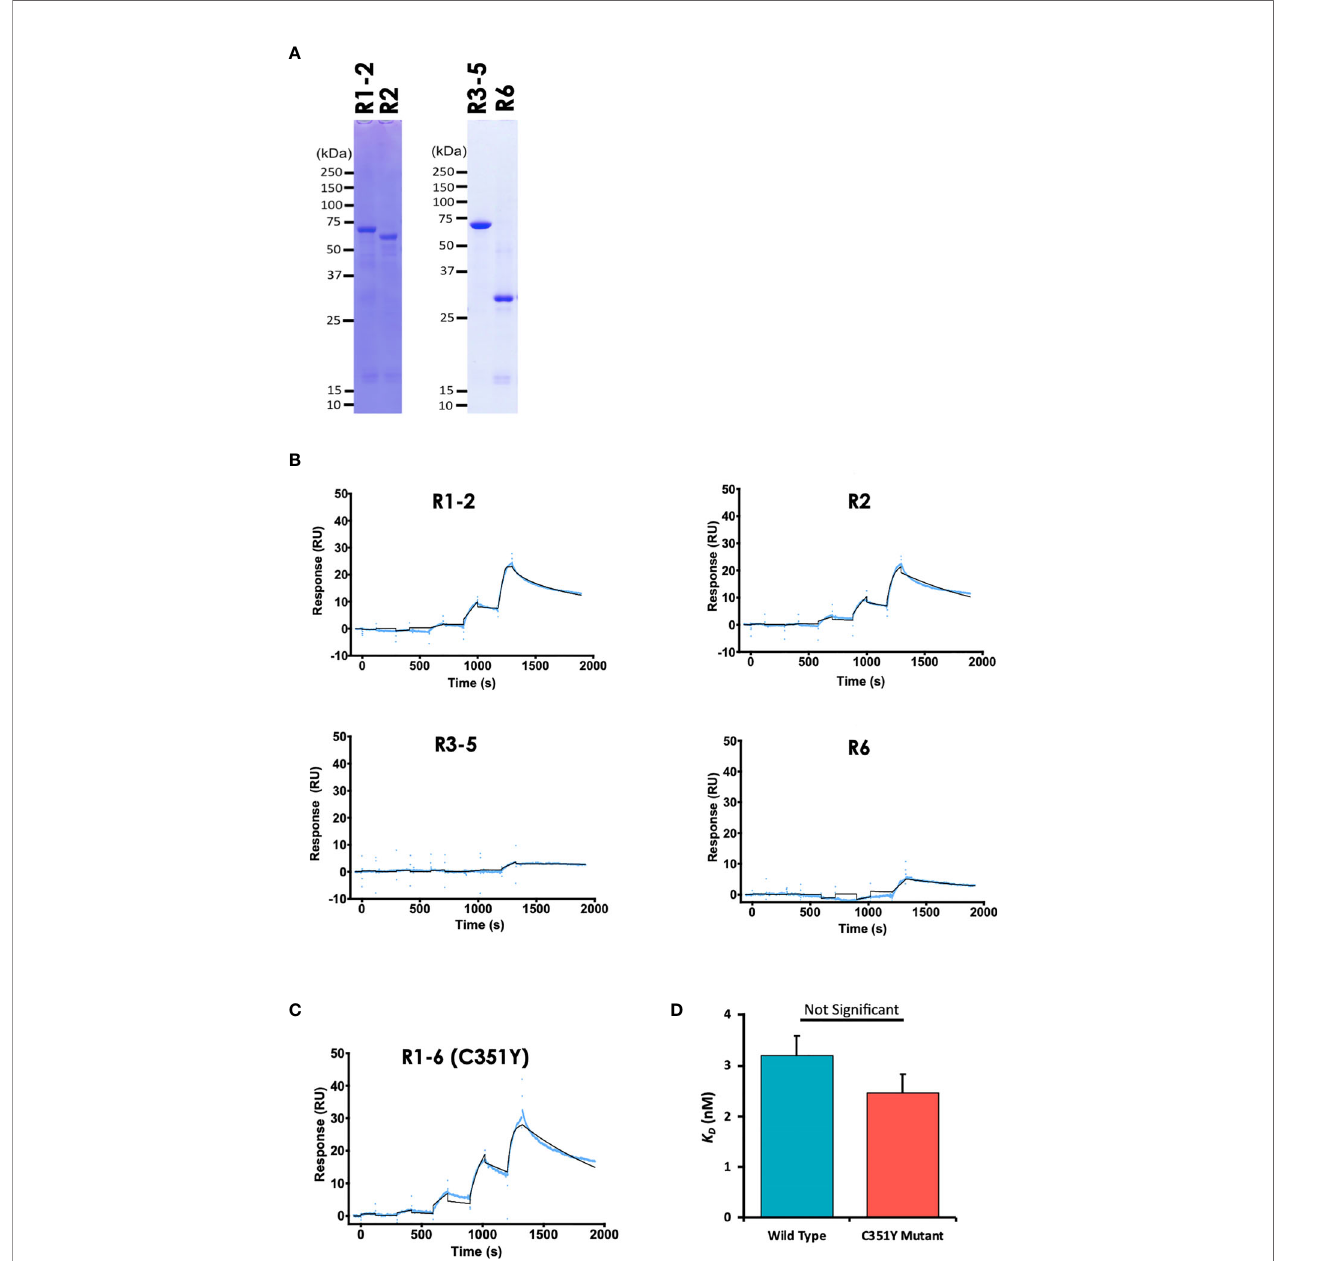
FIGURE 2 | PyEBL interacts with basigin via the Region 2, the Duffy binding-like domain . (A) Recombinant PyEBL truncates namely R1-2, amino acid V 28 -G 437 ; R2, E 113 -G 437 ; R3-5, G 437 -C 717 ; and R6, C 717 -N 788 were expressed as N-terminal GST, C-terminal His-tagged proteins were puri fi ed with Ni-af fi nity columns, resolved by 12.5% SDS-PAGE under reducing conditions, and stained with CBB. Different truncates are shown. (B) Sensorgram of SPR single-cycle kinetic analysis between recombinant PyEBL truncates and recombinant mouse basigin. The SPR Chip used was same as used in Figure 1D with GST tagged Basigin as the analyte. The blue curve represents the actual data-generated sensorgram while the black curve indicates line of fi t used to calculate kinetics parameters. R1-2 and R2 were assayed at an increasing protein concentration of 0.96, 4.8. 24, 120 and 600 nM. R3-5 and R6 were assayed at 62.5, 125, 250, 500 and 1000 nM at 120s and dissociation time of 180s. The last dissociation time was extended to 600s to accurately determine kinetic parameter. (C) Sensorgram of SPR single-cycle kinetic analysis between recombinant PyEBL C351Y and recombinant mouse basigin. The SPR Chip used was same as that used in Figure 1D with GST tagged basigin as the analyte. Blue curve represents the actual data-generated sensorgram while black curve indicates line of fi t used to calculate kinetics parameters. The assay was performed at an increasing analyte concentration of 6, 12, 24, 48, and 96 nM at 120s and dissociation time of 180s. The last dissociation time was extended to 600s to accurately determine kinetic parameters. (D) Comparison of equilibrium binding constants between recombinant Basigin and recombinant PyEBL derived from P. yoelii wild type (PyEBL) or mutant (PyEBL C351Y). Each bar represents average SPR equilibrium binding constants of 4 independent experiments with error bars representing SE of the